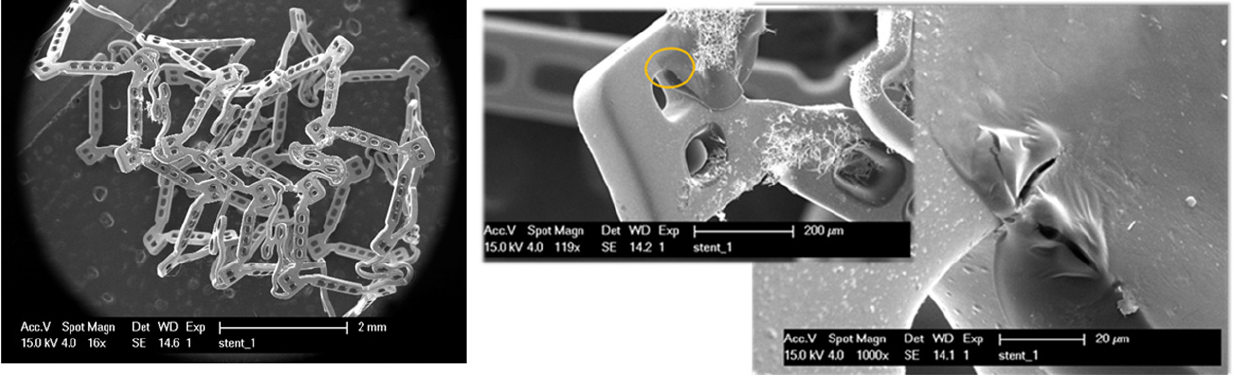
Figure 7: Deformed shape and damages to a reservoir stent.